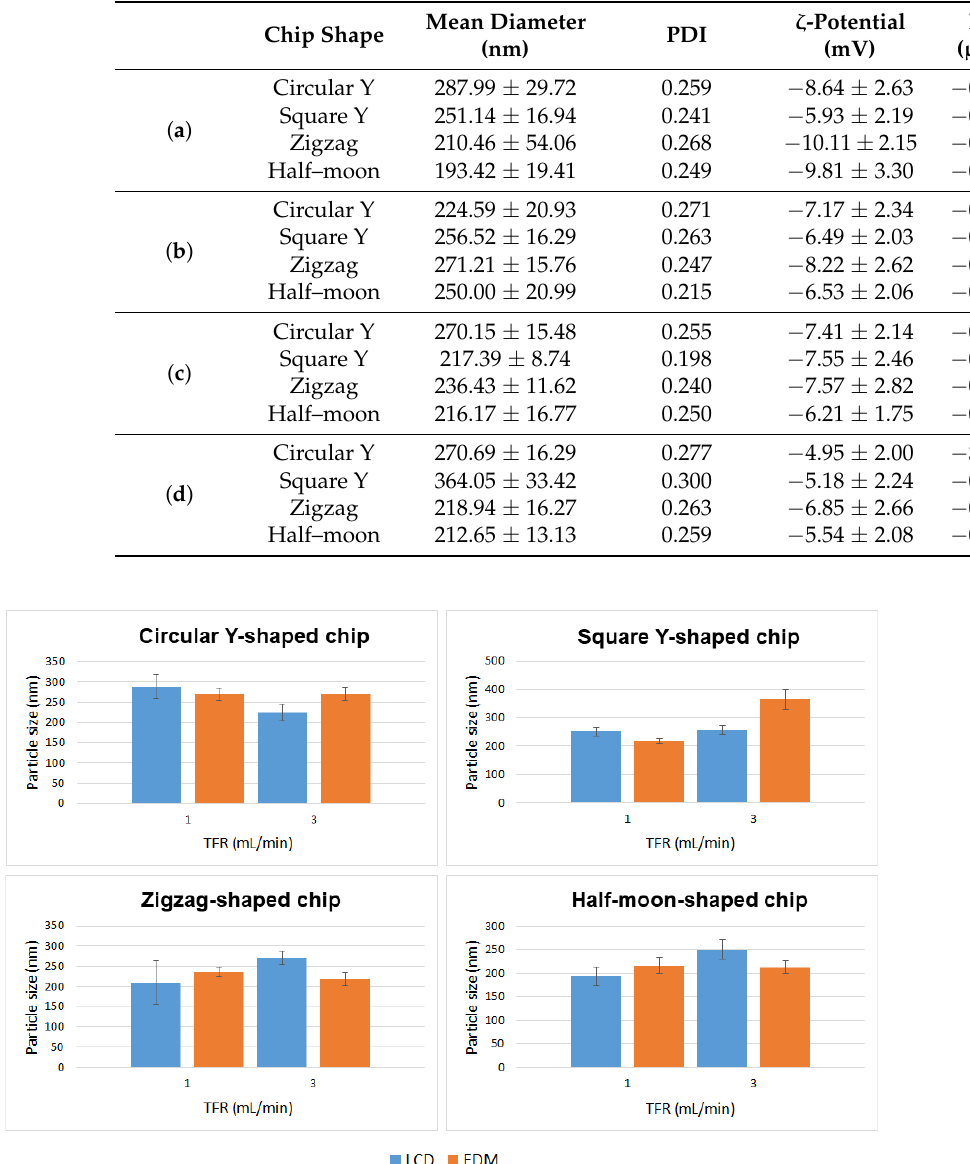
Figure 6. Mean particle size of DMPC liposome formulations prepared using circular Y-shaped, square Y-shaped, zigzag- shaped, and half-moon-shaped chips at TFRs of 1 and 3 mL min −1 .